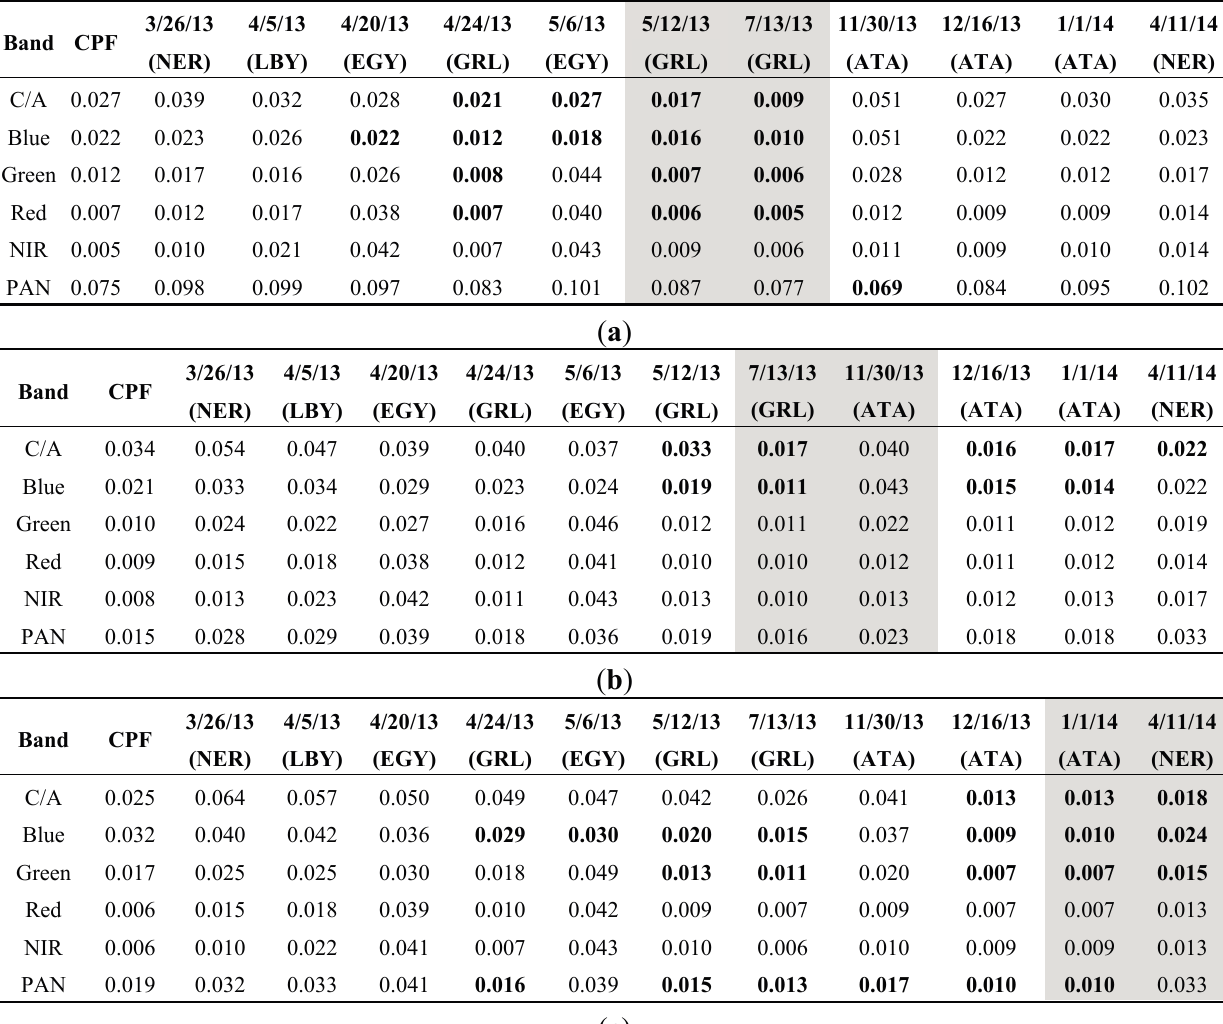
Table 3. Mean streaking metric percentages for the 11/7 site acquired on the following dates: ( a ) 16 June 2013; ( b ) 16 September 2013; ( c ) 1 April 2014. Gray highlighting denotes collects closest to test image acquisition. Bolded numbers mark performance that is superior to the default processing parameters. CPF, calibration parameter